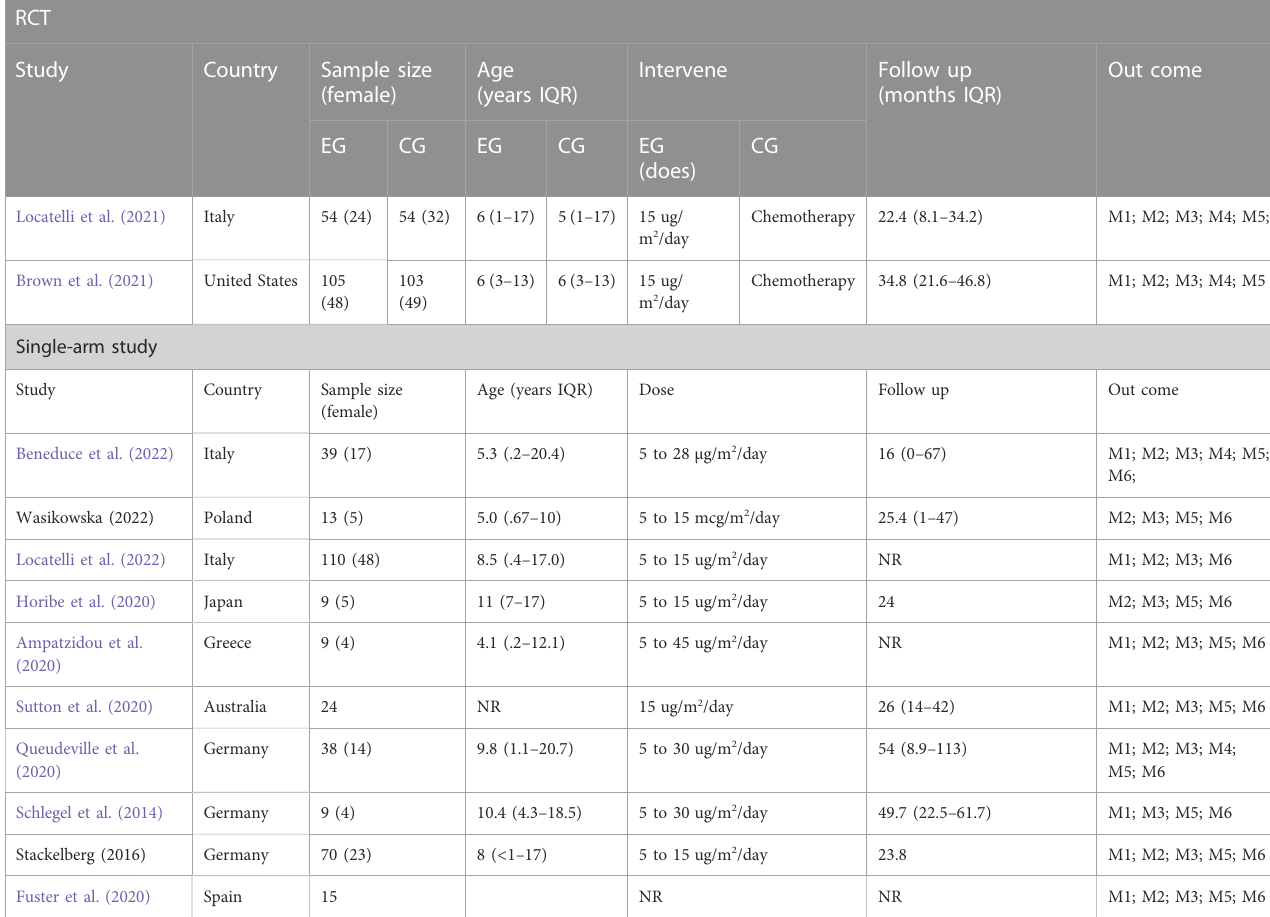
TABLE 1 Characteristics of the studies included in the